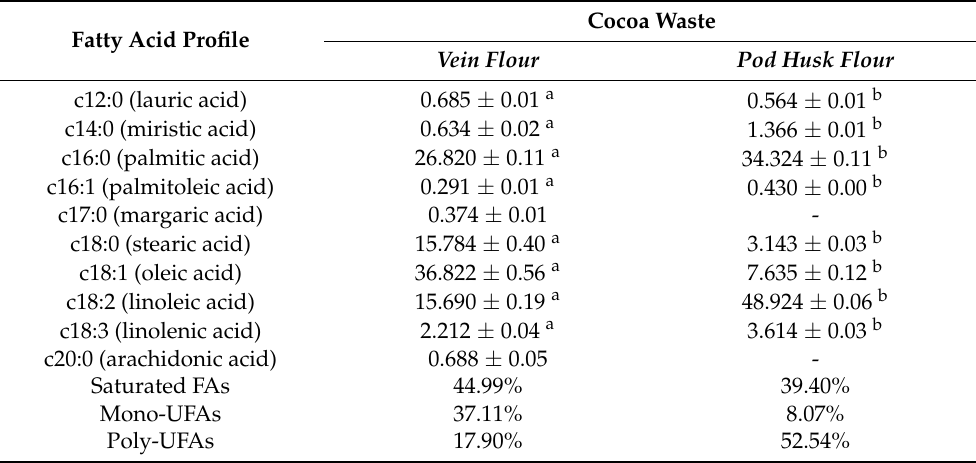
Table 4. Fatty acids profile in flour from vein and pod husk of cocoa (%).